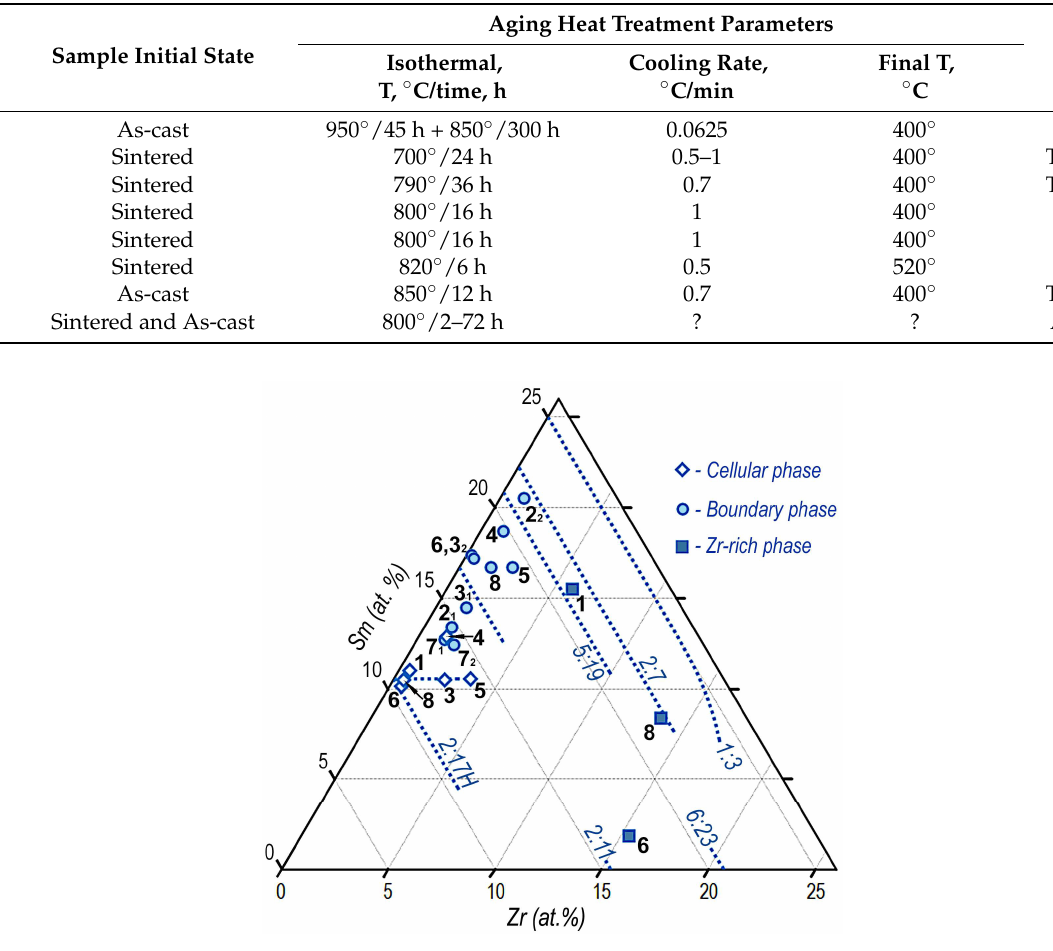
Figure 9. Visual presentation, on coordinates Sm–Zr–(Co,Cu,Fe), of the analysis data for the phase composition of high-coercivity (Sm,Zr)(Co,Cu,Fe) z samples, which are available in [1–8] and given in Tables 3 and 4. Numbers given near symbols correspond to Reference No. (see columns Ref. in Tables 3 and 4).